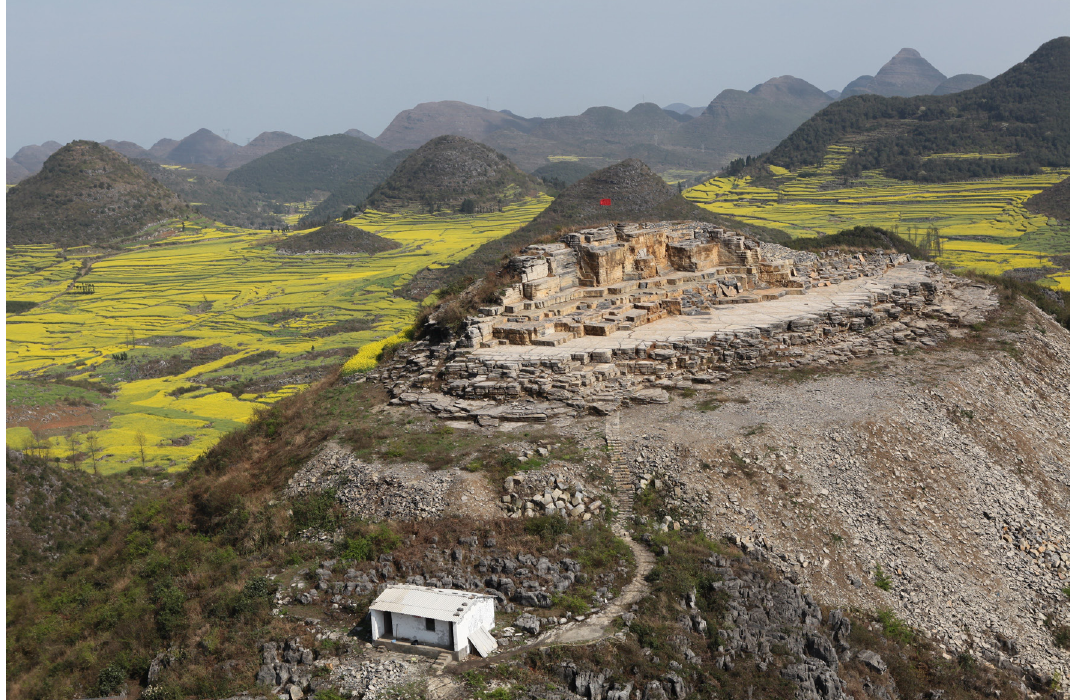
Figure 5. View across Shangshikan Hill, near Daaozi village, the key initial locality that yielded examples of the Luop- ing Biota, showing the layer-by-layer excavation, exposing extensive fossil-rich horizons, including fish-rich horizons on the main platform. The Chinese red flag stands at the top of the hill, and the custodian’s house in the foreground. This location has now been substantially altered to improve access for visitors, as a key site within the